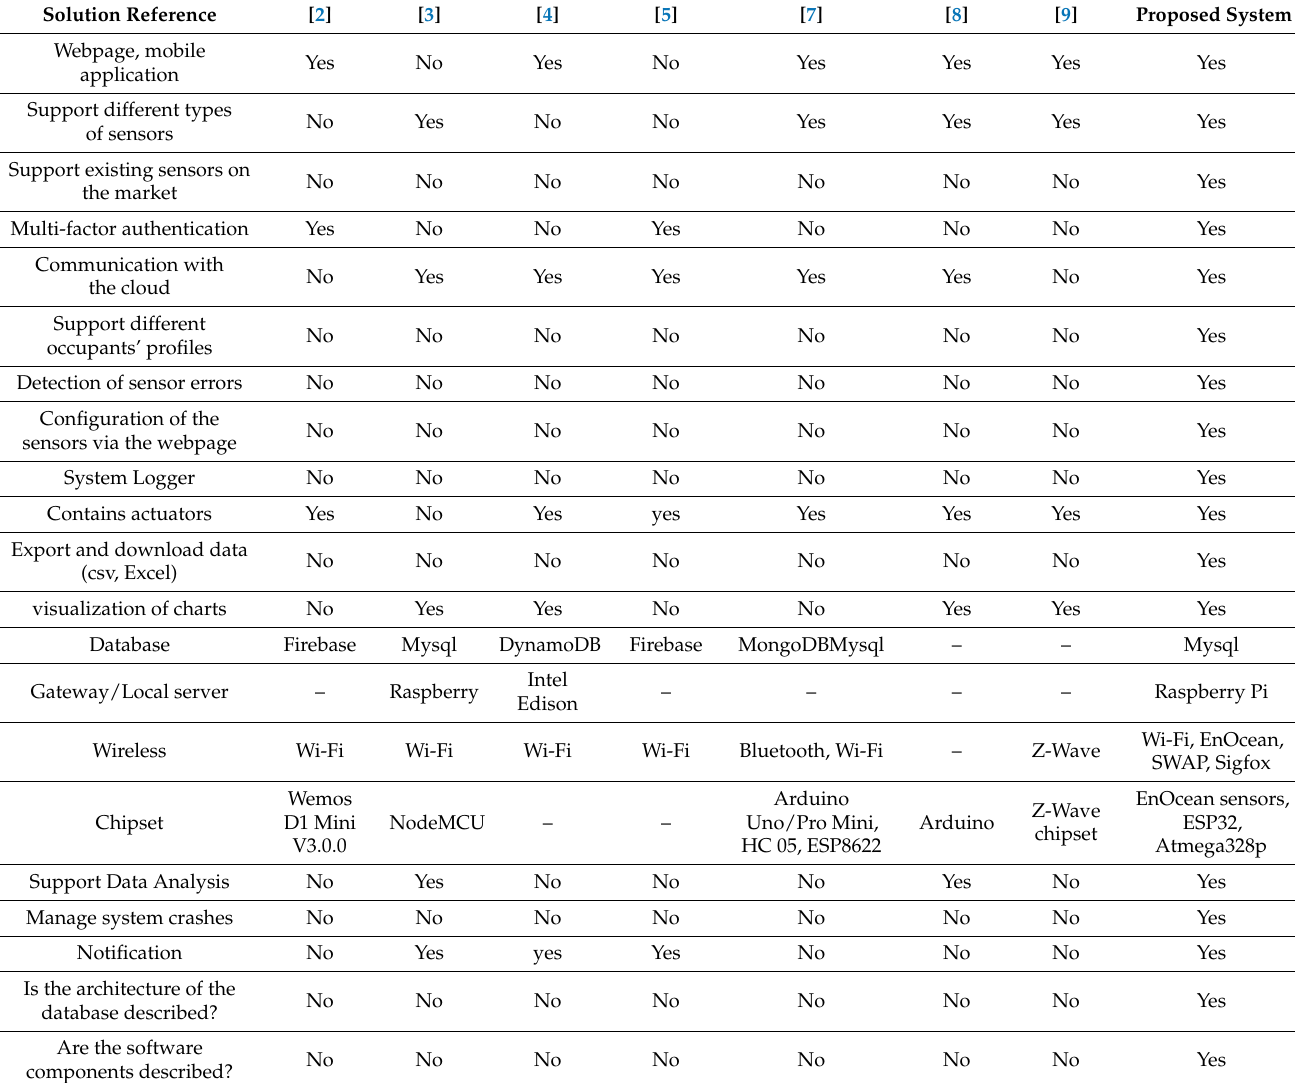
Table 1. Comparison of the proposed solution with other systems from the